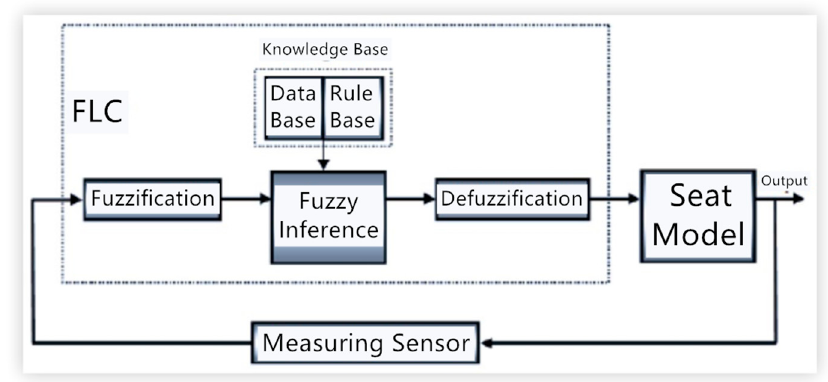
Figure 22. Fuzzy logic controller block [69].